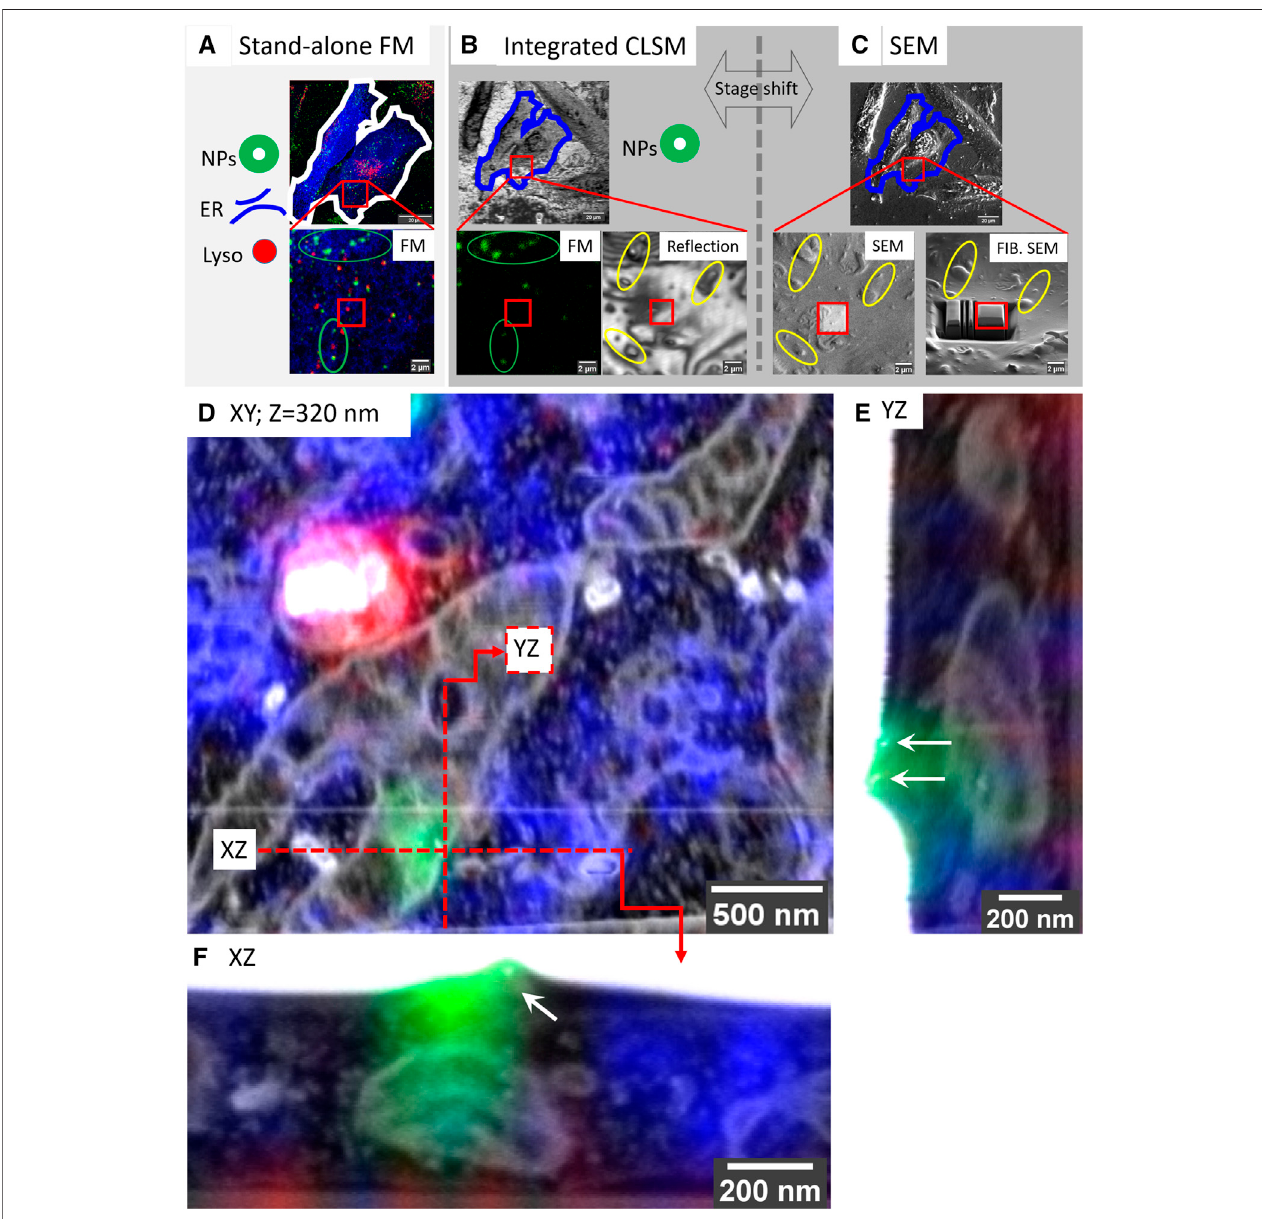
FIGURE 3 | Targeted imaging of minimized volumes in FIB.SEM using iCLSM. (A – C) High-accuracy correlation routine for targeted imaging in FIB.SEM. (A) Maximum intensity projection of a confocal z-stack collected at CLSM from fi xed cells, following optional live-cell imaging. 3D CLSM data show ER (mEmerald-Sec61 β , blue), lysosomes (SiRLyso, red), and endocytic fi ducials (green). Red square indicates the ROI bearing a single lysosome selected for targeted volume EM. (B) The cells and the ROI are traced back after EM sample preparation. Fluorescence of endocytic fi ducials is visualized by iCLSM and correlated to the CLSM data (green ellipses), providing the coordinates of the ROI, even when the ROI itself has no fi ducial particles. Re fl ection image collected by iCLSM provides topographic information correlated with SEM for fi ne alignment (yellow ellipses). (C) Once precisely located, the Pt layer is deposited to protect the ROI from FIB, and trenches are prepared for imaging only the small ROI area. (D) The small ROI, bearing a single lysosome not reached by endocytic fi ducial particles, is targeted and imaged in FIB.SEM. 3D CLSM data, ER, lysosomes, and endocytic fi ducials, are overlaid with the 3D FIB.SEM data. (E,F) Two fi ducial particles located on the plasma membrane are used as a blind target to assess correlation/targeting ef fi ciency. Green fl uorescence signal of the particles is correlated to their gold core with an accuracy of 60 nm in X (E) , 90 nm in Y (F), and 330 nm in Z.